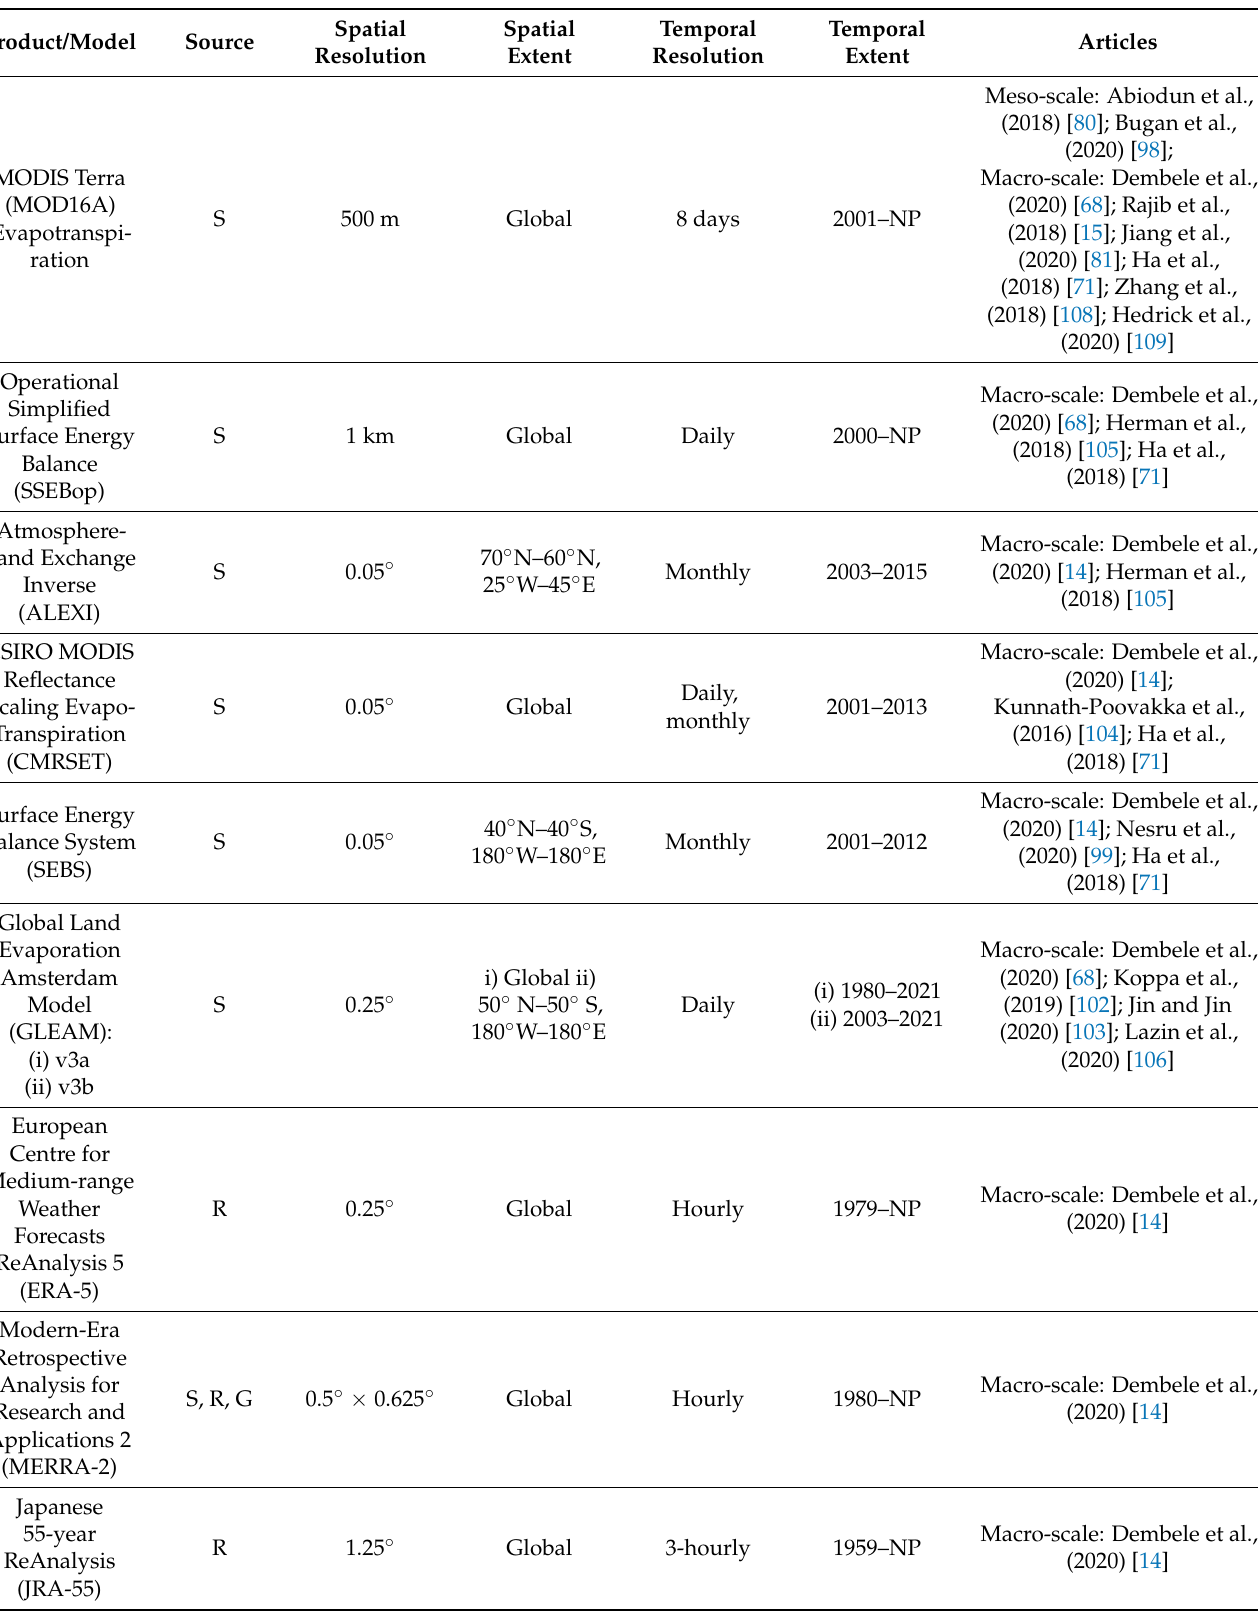
Table A7. Evapotranspiration (ET) products used in reviewed